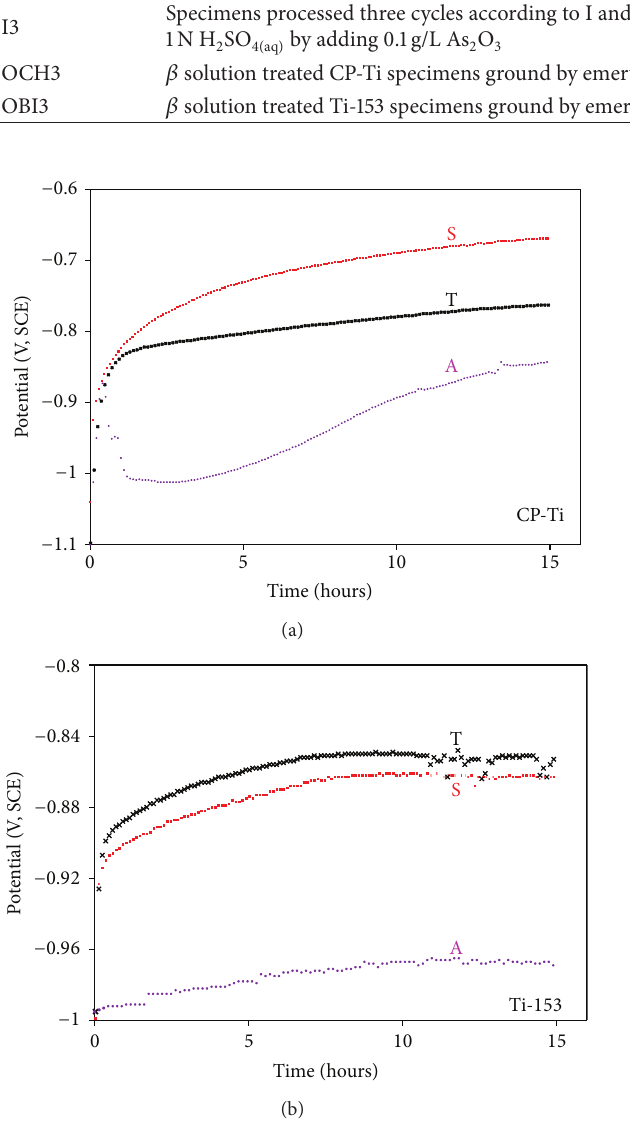
Figure 4: V - t curves for (a) CP-Ti and (b) Ti-153 specimens cathodic charged in various electrolytes.